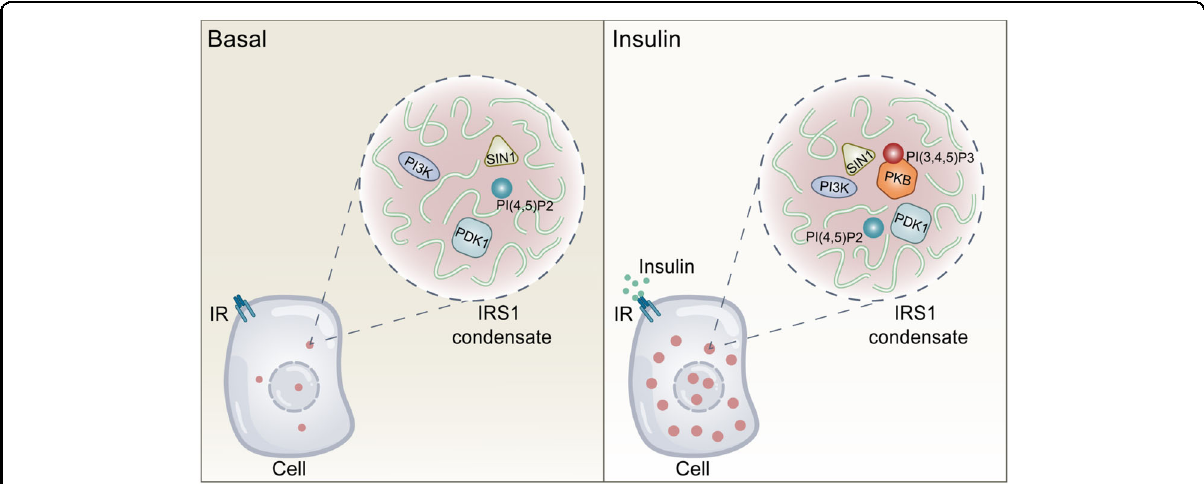
Fig. 8 A model of IRS1 condensates as intracellular insulin signal hubs. A schematic illustration of IRS1 condensates serving as intracellular signal hubs to execute insulin signal transduction. IRS1 condensates form through LLPS in concentration- or insulin-dependent manners. At the basal state, multiple components including PI(4,5)P2, PI3K, PDK1, and SIN1 are present in IRS1 condensates. Upon insulin stimulation, more components such as PIP3 and PKB appear in IRS1 condensates to mediate insulin signal